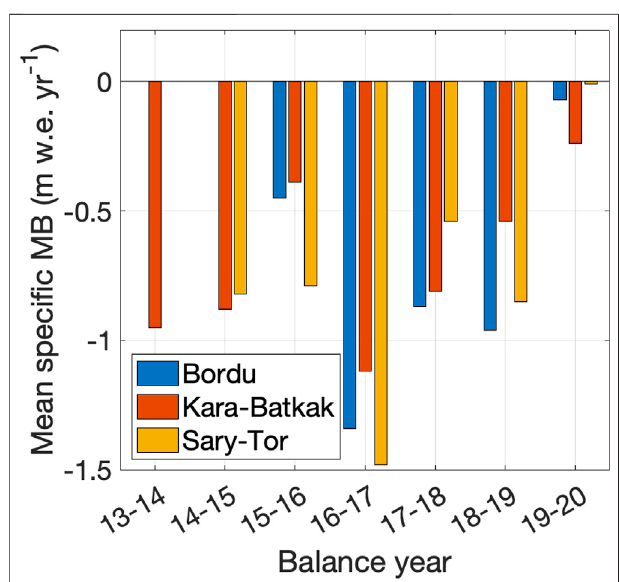
FIGURE 3 | Annual mean speci fi c mass balance (MB) of the different glaciers since the re-initiation of the monitoring programmes (in m w.e. yr − 1 ).